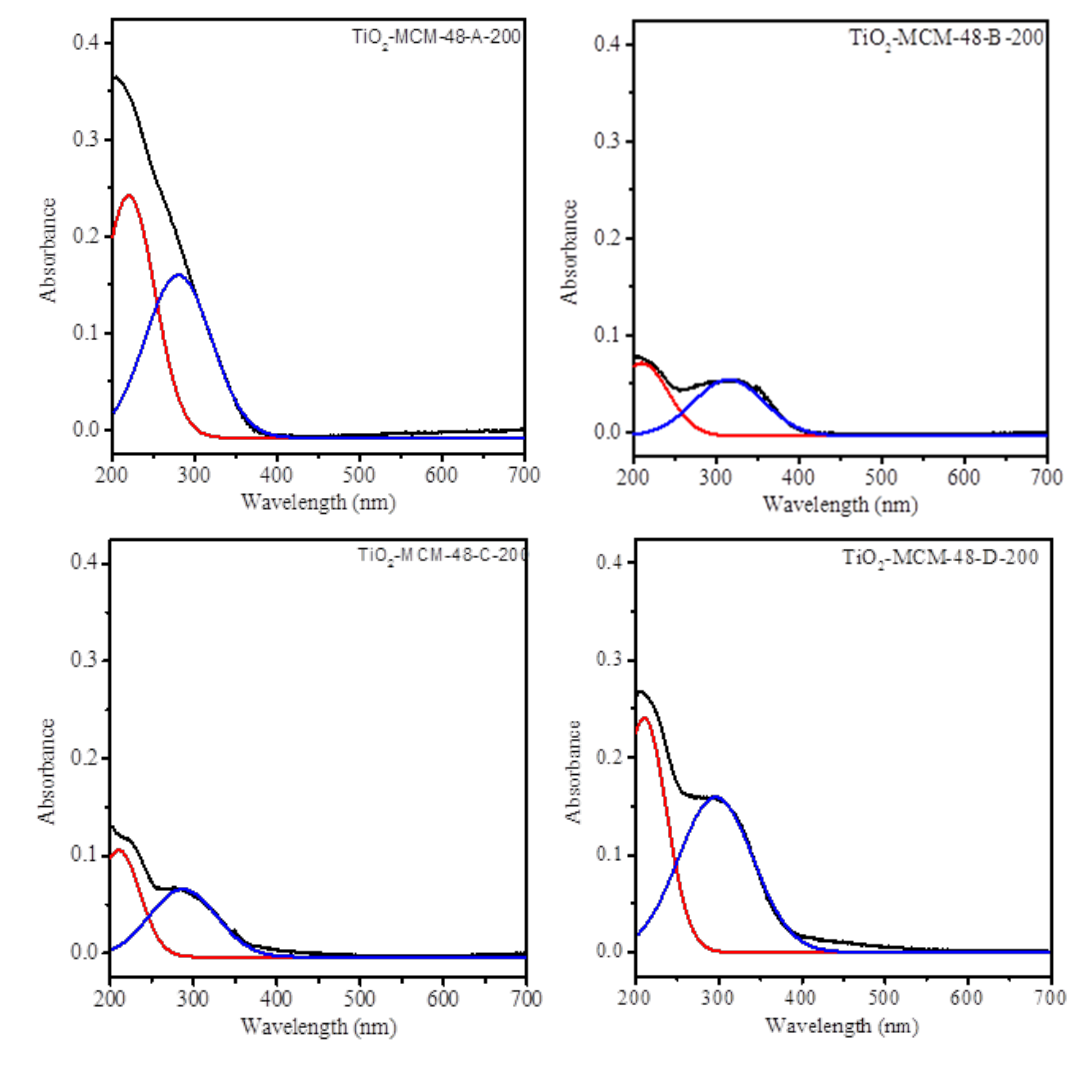
Figure 6. UV-Vis DRS of TiO 2 -MCM-48-200 materials by four different methods. The bold black line shows the original UV-Vis spectra whereas the red and blue bold lines indicate the de-convoluted